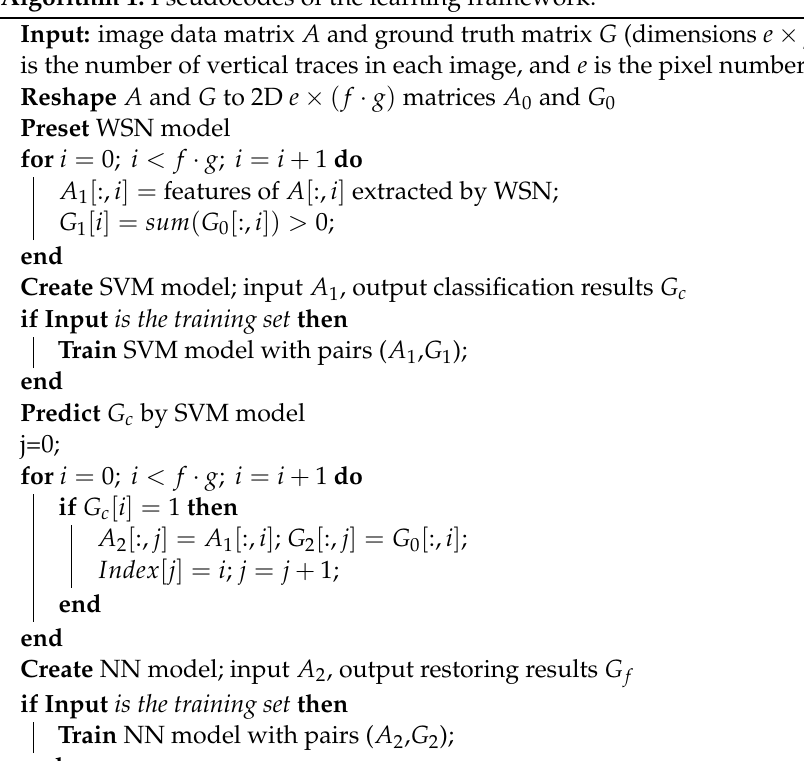
Algorithm 1: Pseudocodes of the learning